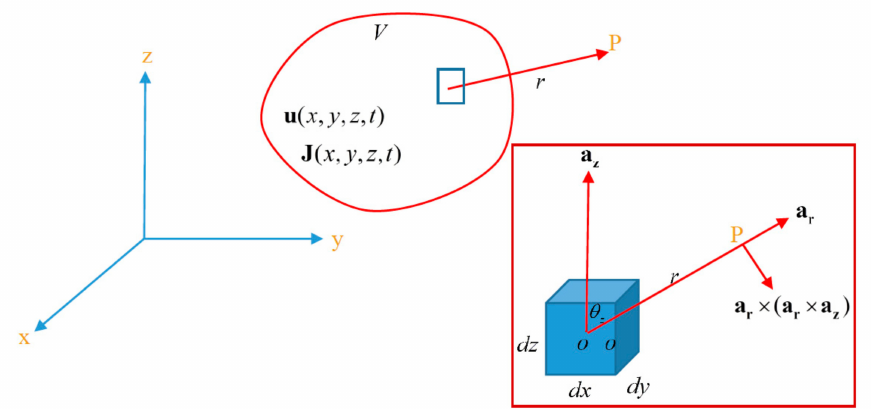
Figure 2. Geometry relevant to the generalization of the field equations based on procedures I and II. The volume where the current densities and speed of propagation are defined is divided into elementary cubical volumes. The sides of the elementary cubical volume coincide with the x , y, and z axes. The unit vectors in the direction of the positive x , y, and z axes are denoted by a x , a y , and a z . Inset: Geometry used in deriving the electromagnetic fields pertinent to the currents directed along the z -direction. The coordinates of point O located at the center of the element are taken to be x , y , z . Note that cos θ z = a z · a r